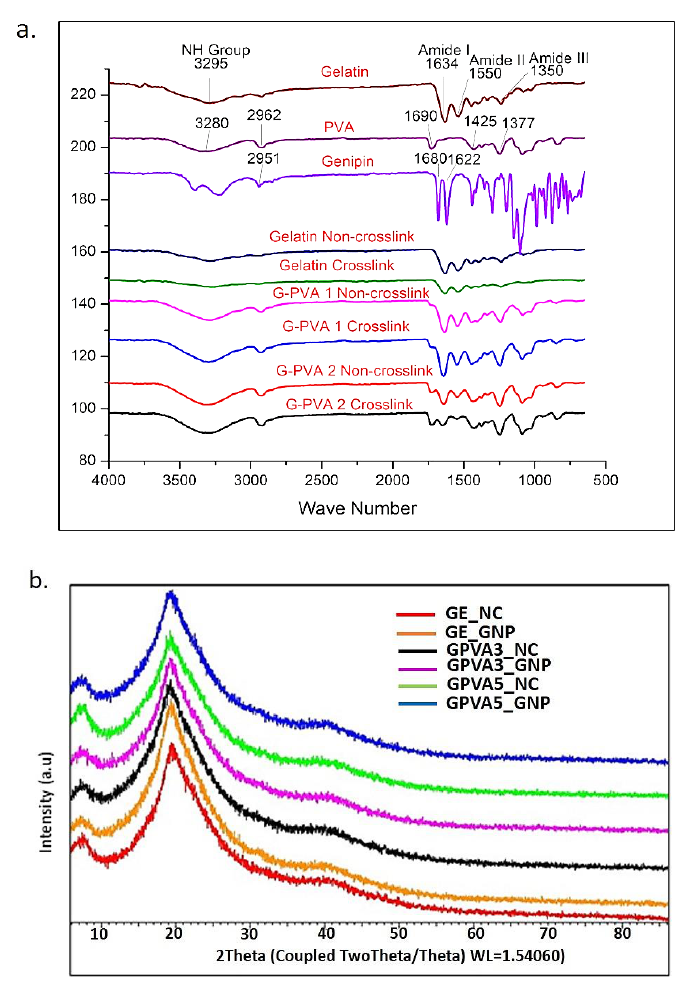
Figure 5. Chemical characterisation of hydrogel. ( a ) FTIR spectra of pure gelatin, PVA, genipin, and fabricated hydrogels, and ( b ) crystallinity of hydrogels via X-ray diffraction analysis (XRD). The XRD profiles of gelatin – PVA hydrogels are represented in Figure 5b. The XRD test was frequently used to identify the crystalline phase of the scaffolds based on the diffraction peak orientation, peak pattern, and the measurement of the mean crystalline sizes of the gelatin, PVA, and genipin within the hydrogel network. As shown in Figure 5b, a broad peak at 20° is related to the polymer network. The XRD result demonstrated that the presence of gelatin, PVA, and genipin inhibited the crystallisation of crosslinked and non-crosslinked gelatin – PVA hydrogels. Table 1 shows the percentage of crystallinity and the amorphous level of hydrogels. Table 1. Crystallinity and amorphous levels in GPVA hydrogels via XRD analysis. Hydrogels